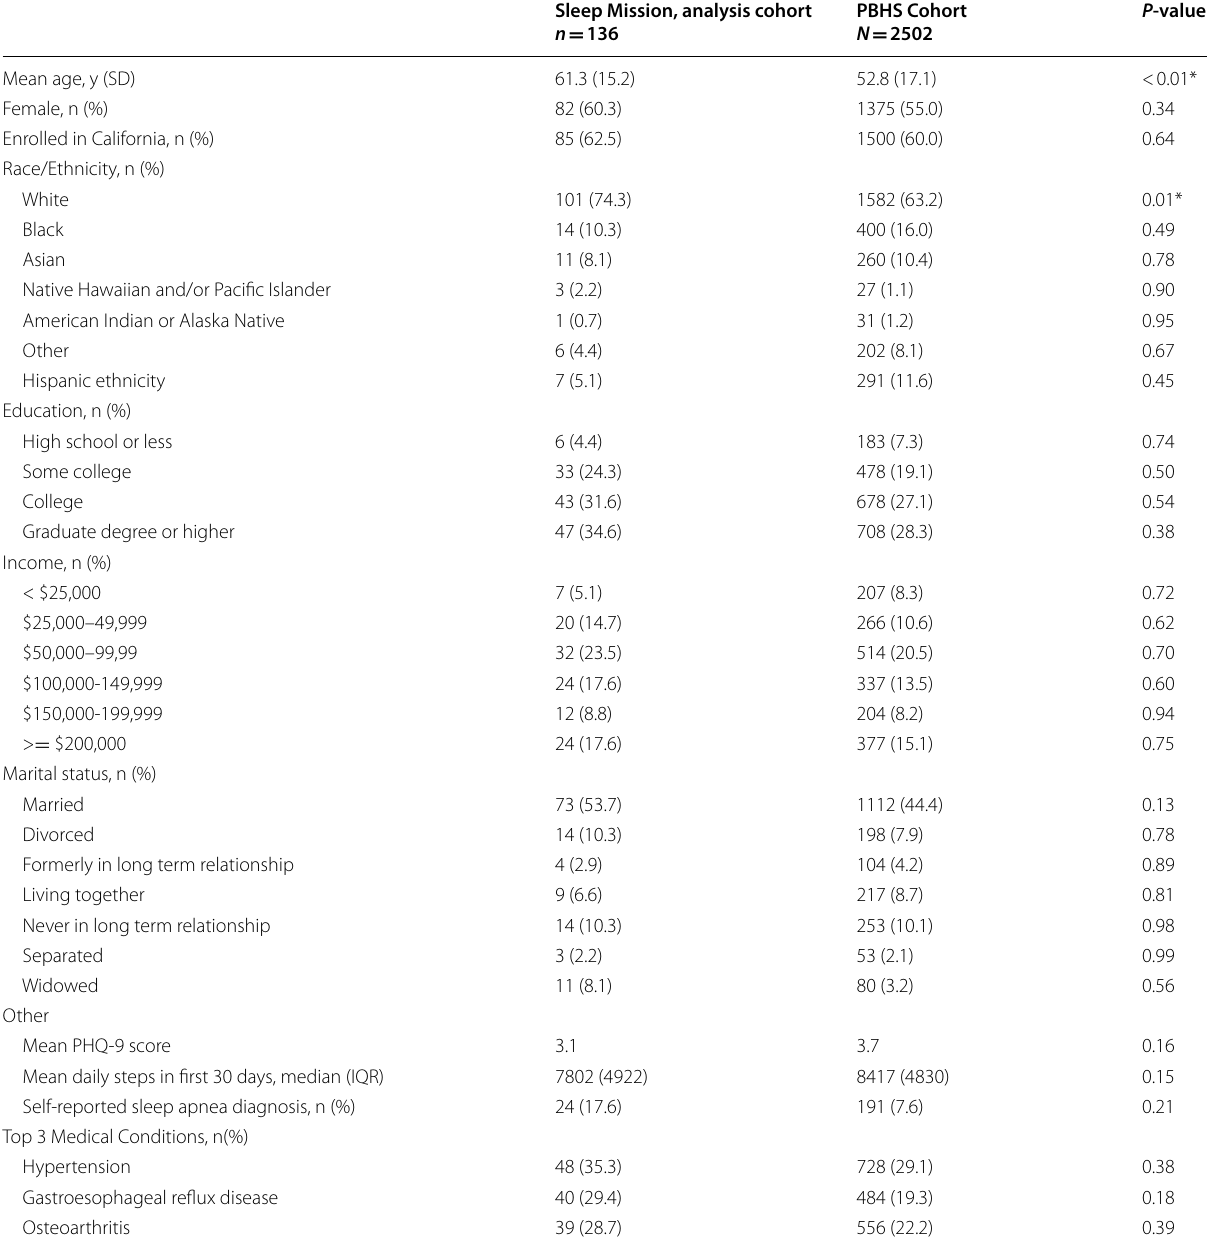
Table 1 Study population characteristics, participants who opted in and contributed data for the Sleep Mission. For reference, the characteristics of the full PBHS cohort are included; characteristics for which this study cohort showed significant differences compared to the originating PBHS population are indicated in the column with the p -value for these comparisons